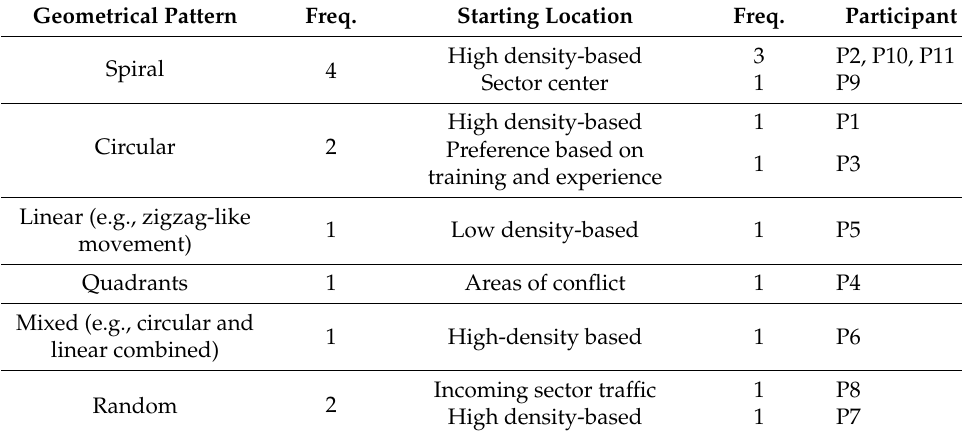
Table 2. Shape of visual search strategy and starting